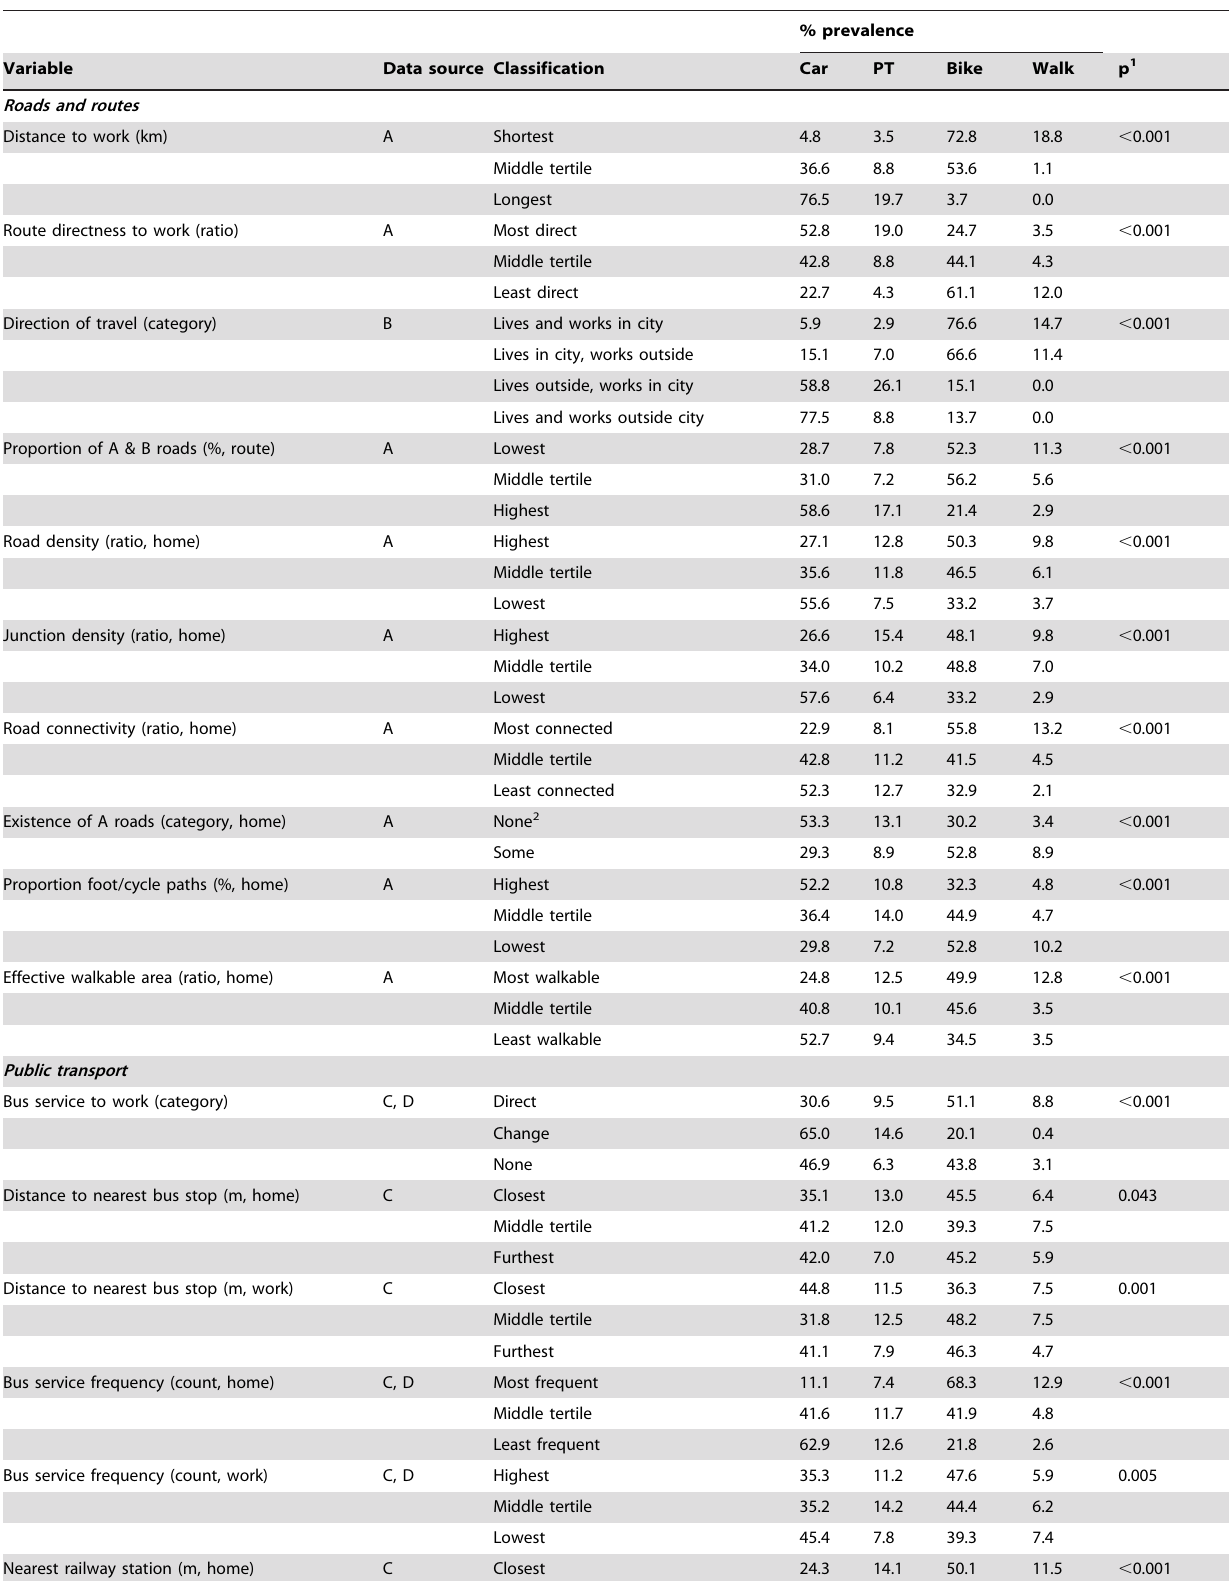
Table 1. Prevalence of travel mode by levels of environmental exposure variables.